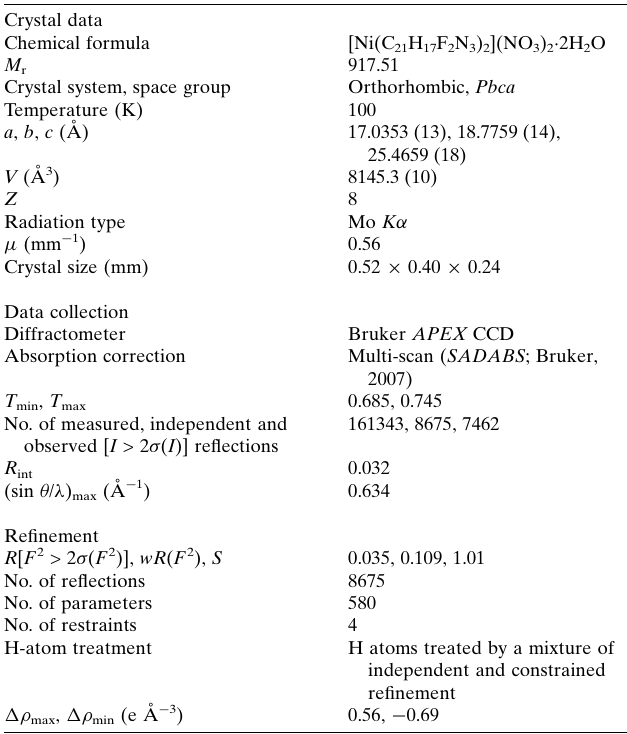
Table 2 Experimental details. Crystal data Chemical